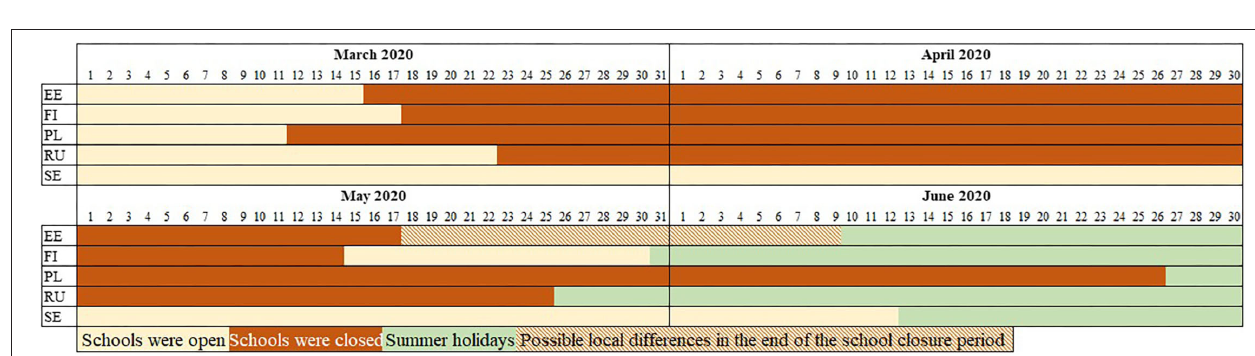
100,000 population in a 14-day notification rate. Russia was the only country among the five to show a decrease in rates after December 2020. In comparison to the other BSR countries, Finland had a very mild second wave that started in